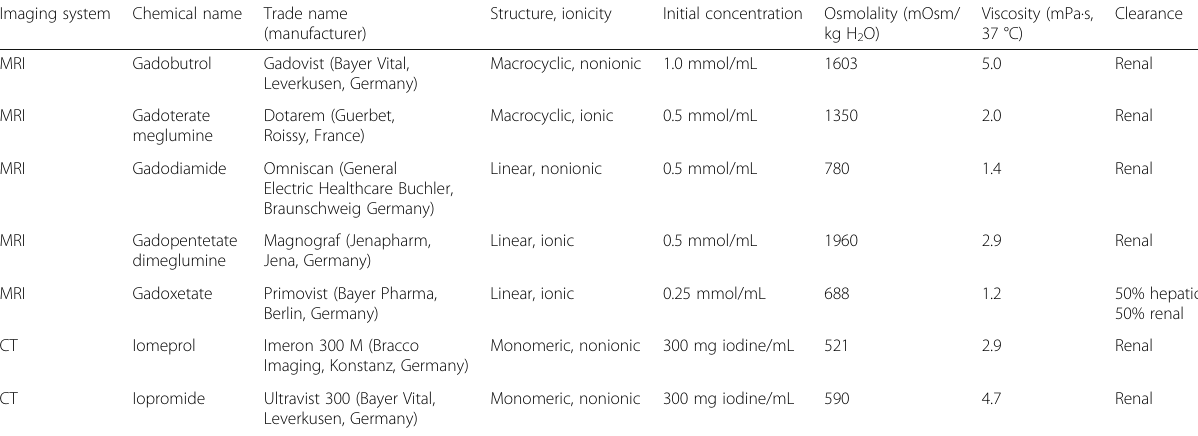
Table 1 List of contrast agents applied in this in vitro study Imaging system Chemical name Trade name Structure, (manufacturer)